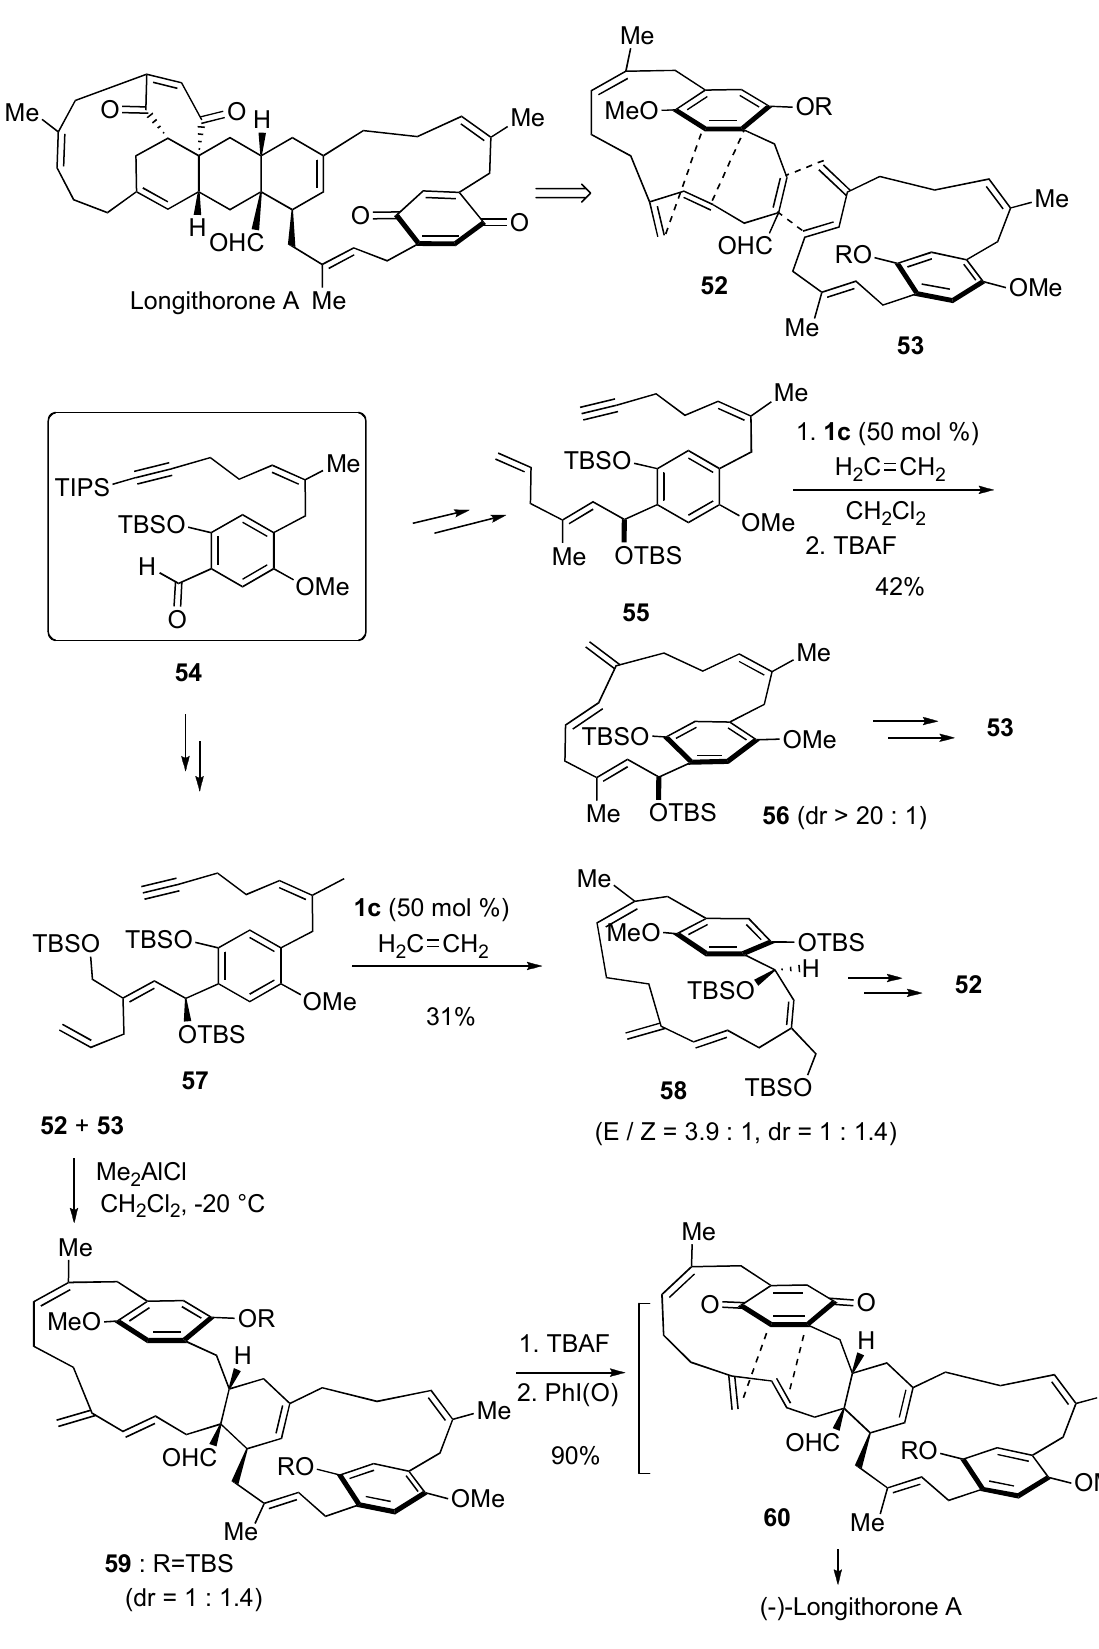
Scheme 16. Total synthesis of (-)-longithorone